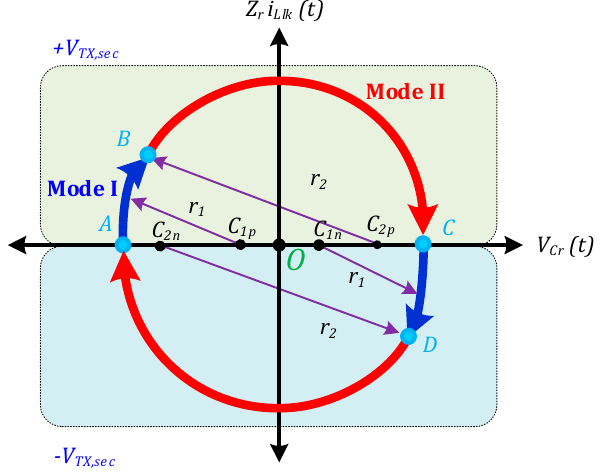
Figure 5. The state-plane trajectory of the resonance tank of the proposed SRC.